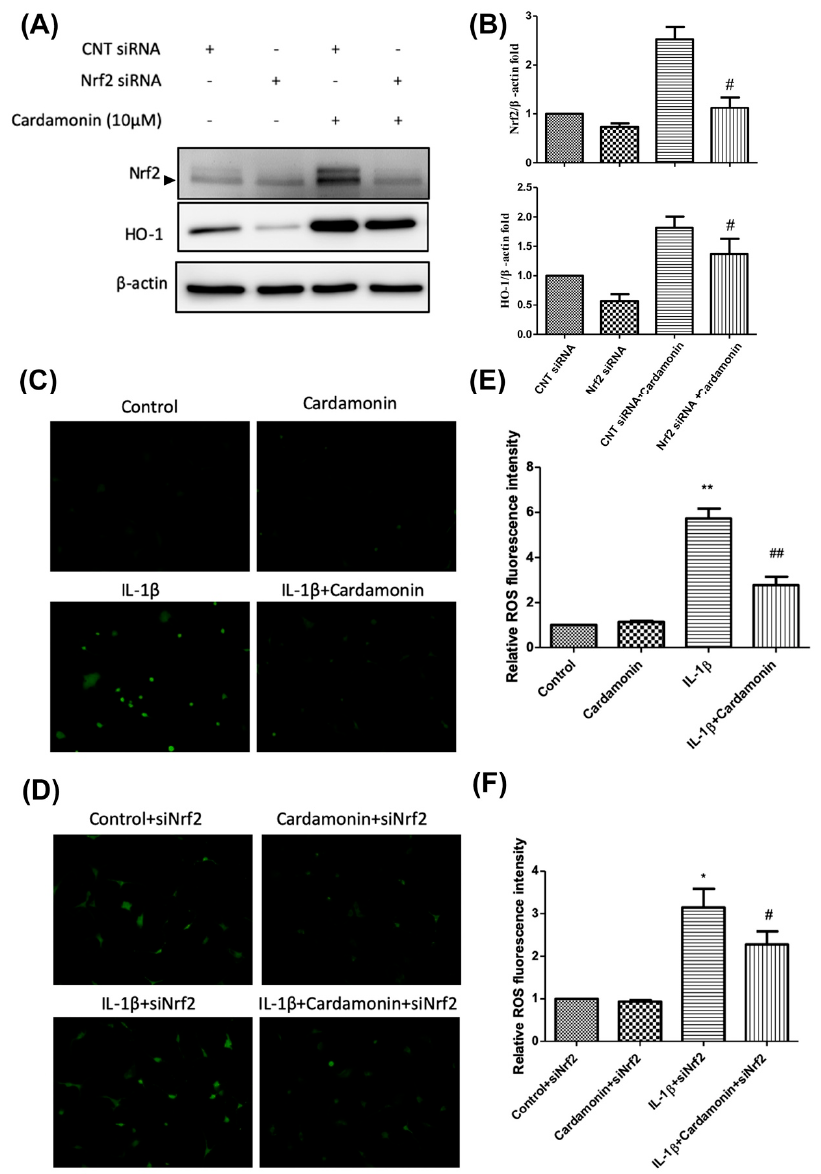
Figure 6. Inhibited HO-1 expression and induced ROS generation in IL-1 β -stimulated human OA chondrocytes were used Nrf2 siRNA. ( A ) Representative Western blot analysis illustrating the effects of incubating chondrocytes with CNT-siRNA, Nrf2-siRNA, CNT-siRNA+ cardamonin, or Nrf2-siRNA+ cardamonin for 2 h. ( B ) Nrf2 and HO-1 protein expression levels showing the effects of cardamonin treatment in chondrocytes. ( C , D ) Chondrocytes were incubated with cardamonin, siNrf2 for 2 h, and then stimulated with IL-1 β for 2 h. Treatment with cardamonin alone or cardamonin with siNrf2 knock down suppressed IL-1 β -stimulated ROS generation in chondrocytes. ( E , F ) ROS generation was detected and quantified in terms of fluorescence intensity. All data comes from at least three independent experiments, and their significance were as follows: IL-1 β group and the groups treated with cardamonin alone or with cardamonin + siNrf2 knock down are indicated by an asterisk (*) or a hash symbol (#). *, # p < 0.05; **, ## p <